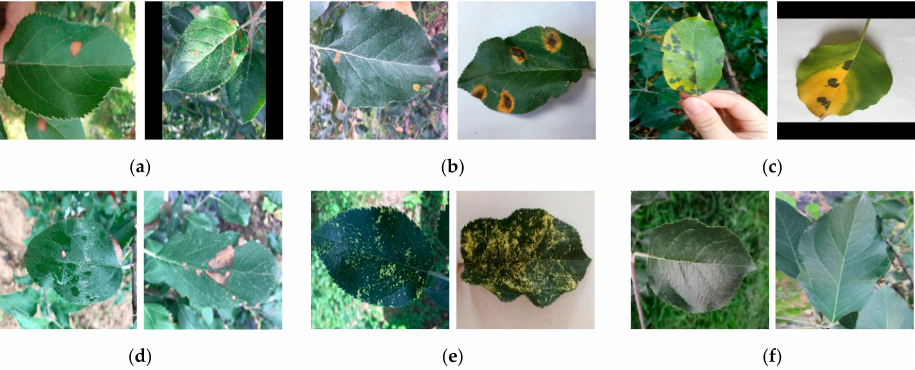
Figure 1. The examples of ATLDD dataset: ( a ) Alternaria leaf spot; ( b ) Rust disease; ( c ) Brown spot disease; ( d ) Gray spot disease; ( e ) Mosaic disease; ( f ) Healthy